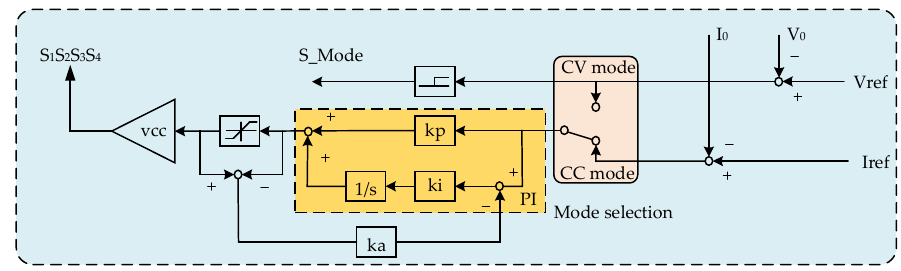
Figure 18. Closed-loop control method of the converter.